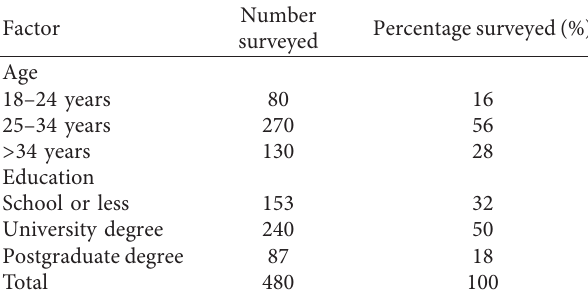
Table 1: Demographics date of the surveyed